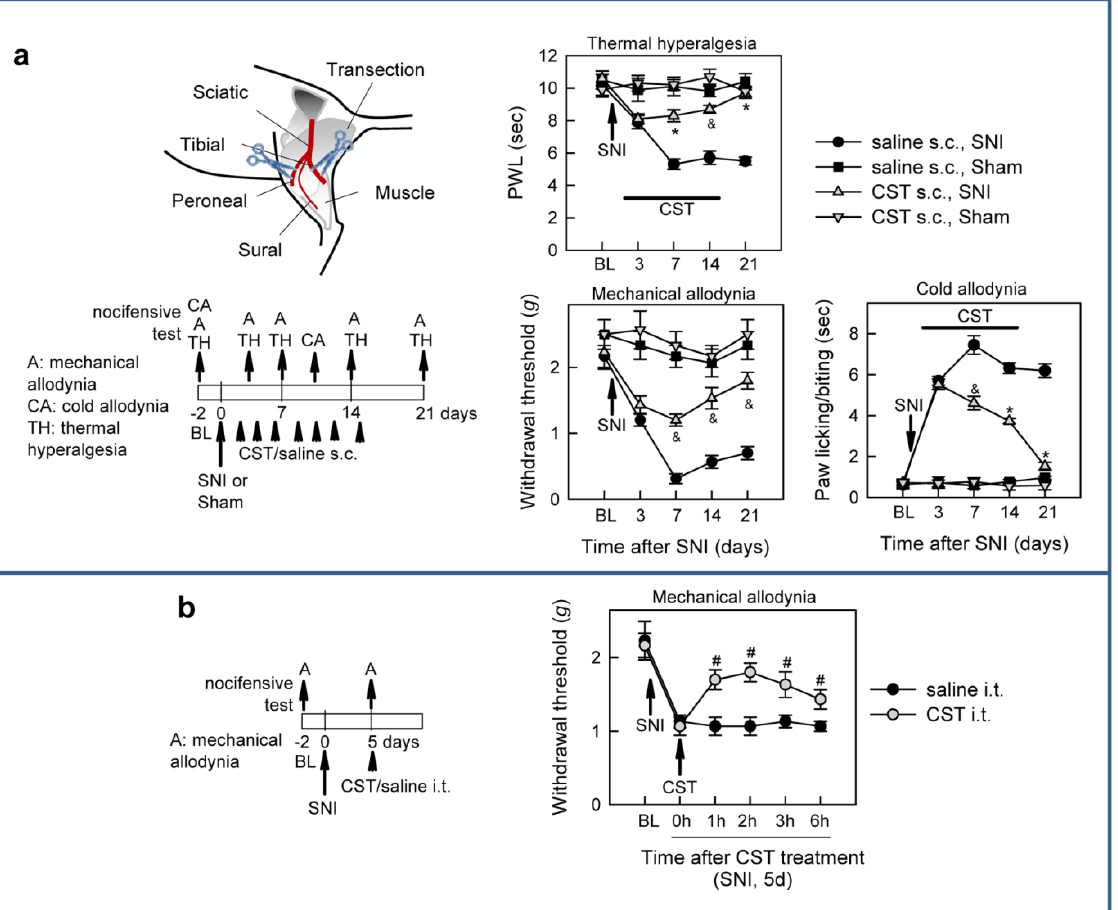
Figure 3. Cortistatin alleviated thermal hyperalgesia and allodynia in a model of spared nerve injury (SNI). ( a ) Effects of local (s.c. 1 µg) cortistatin injection (every other day starting 2 days after SNI-surgery until day 15, as indicated in the scheme) on thermal hyperalgesia represented by paw withdrawal latency (PWL) in response to radiant heat, on mechanical allodynia represented by withdrawal threshold (in g) to plantar von Frey hair application in hind paws ipsilateral to the surgery, and on cold allodynia determined by duration of hind paw licking and biting in response to acetone application to the paw ipsilateral to the surgery, before (BL, baseline) or at different times after SNI. Sham-operated mice were used as controls of reference. n = 6 mice/group. * p < 0.0001, & p < 0.01 vs. saline-treated mice. ( b ) Effects of a single central (i.t., 20 ng) cortistatin injection on mechanical allodynia measured 5 days after SNI induction. n = 6 mice/group. # p < 0.05 vs. saline-treated mice. All data represents mean ± SEM.